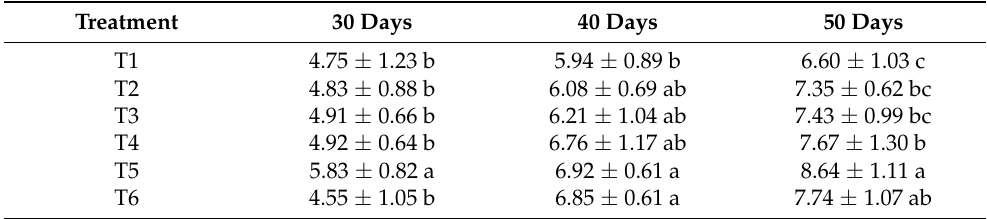
Table 3. Above-ground height (cm) of Chinese cabbage at different treatments (see Section 2.2.2) and periods